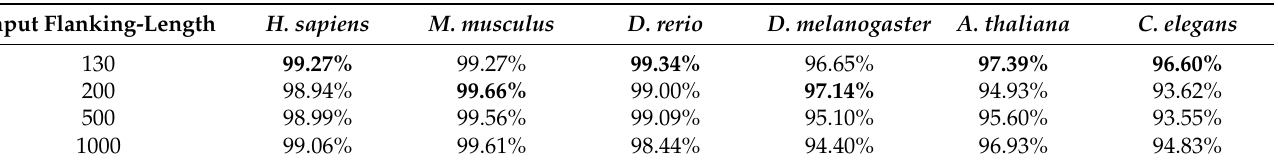
Table 2. Accuracy of Deep Splicer with input genetic sequences of different flanking-lengths. The highest accuracy of each organism is shown in